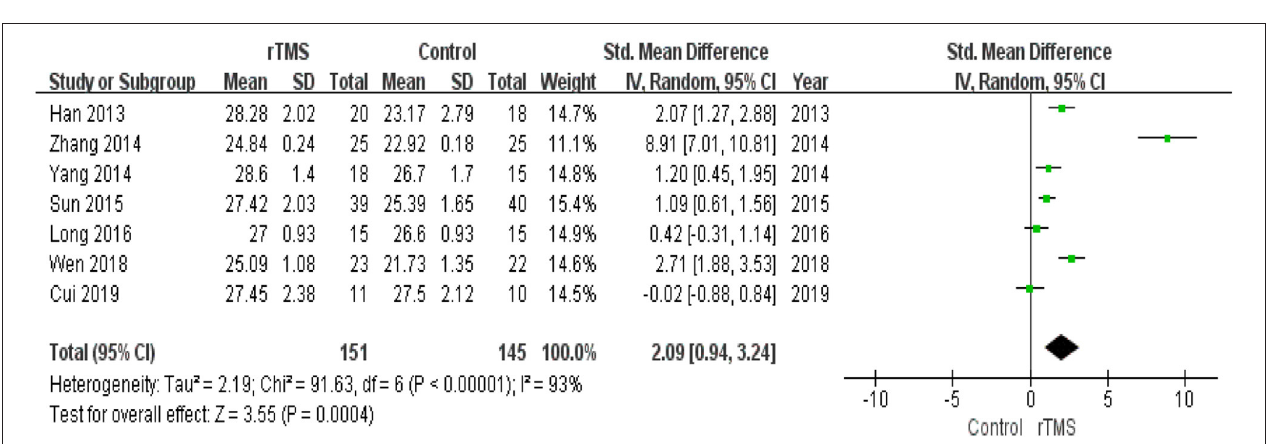
FIGURE 4 | Forest plot of the comparison between the repetitive transcranial magnetic stimulation and control groups with respect to global cognitive